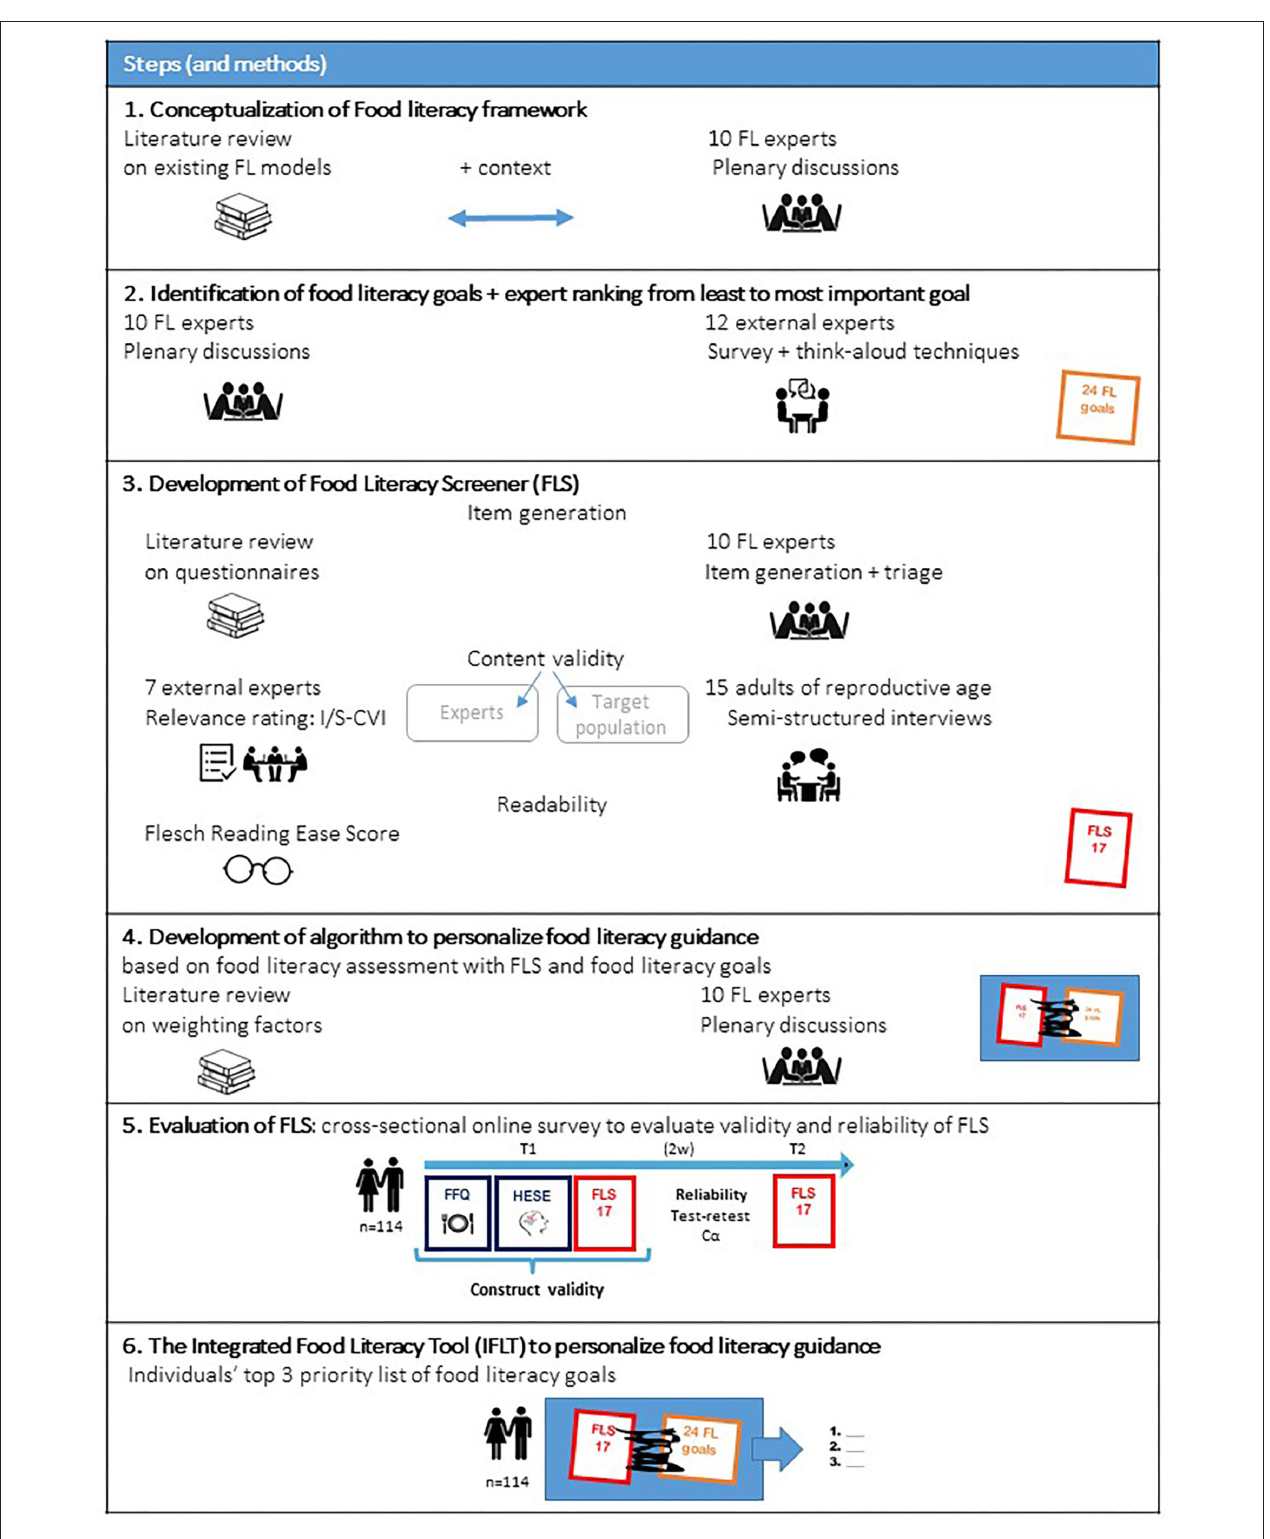
FIGURE 1 | Step-wise approach for IFLT development. FL, Food Literacy; I-CVI, Item Content Validity Index; S-CVI, Scale Content Validity Index; FLS, Food Literacy Screener; IFLT, Integrated Food Literacy Tool; FFQ, Food Frequency Questionnaire; C α , Cronbach’s alpha; HESE, Healthy Eating Self-Efficacy.